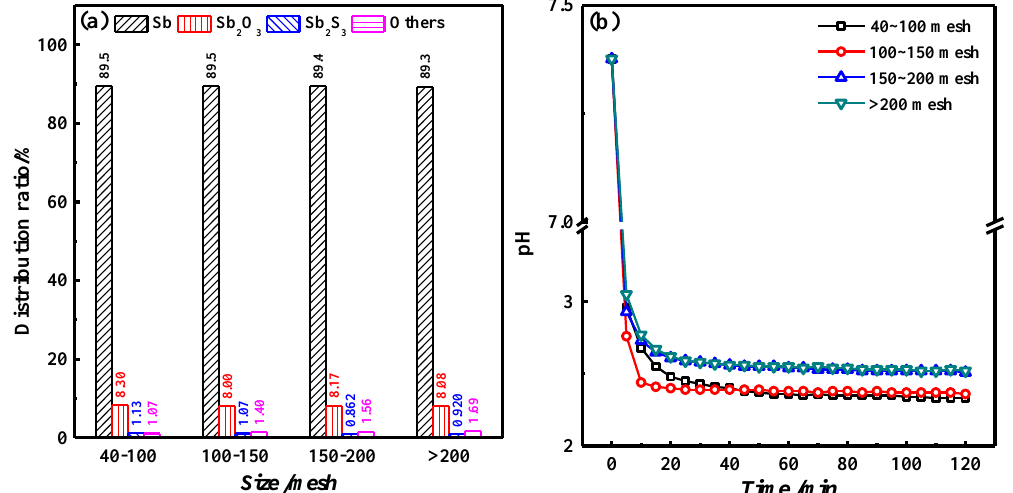
Figure 6. ( a ) Phase distribution ratio of Sb in the roasted products with different C powder sizes; and ( b ) pH values of KMnO 4 solution.